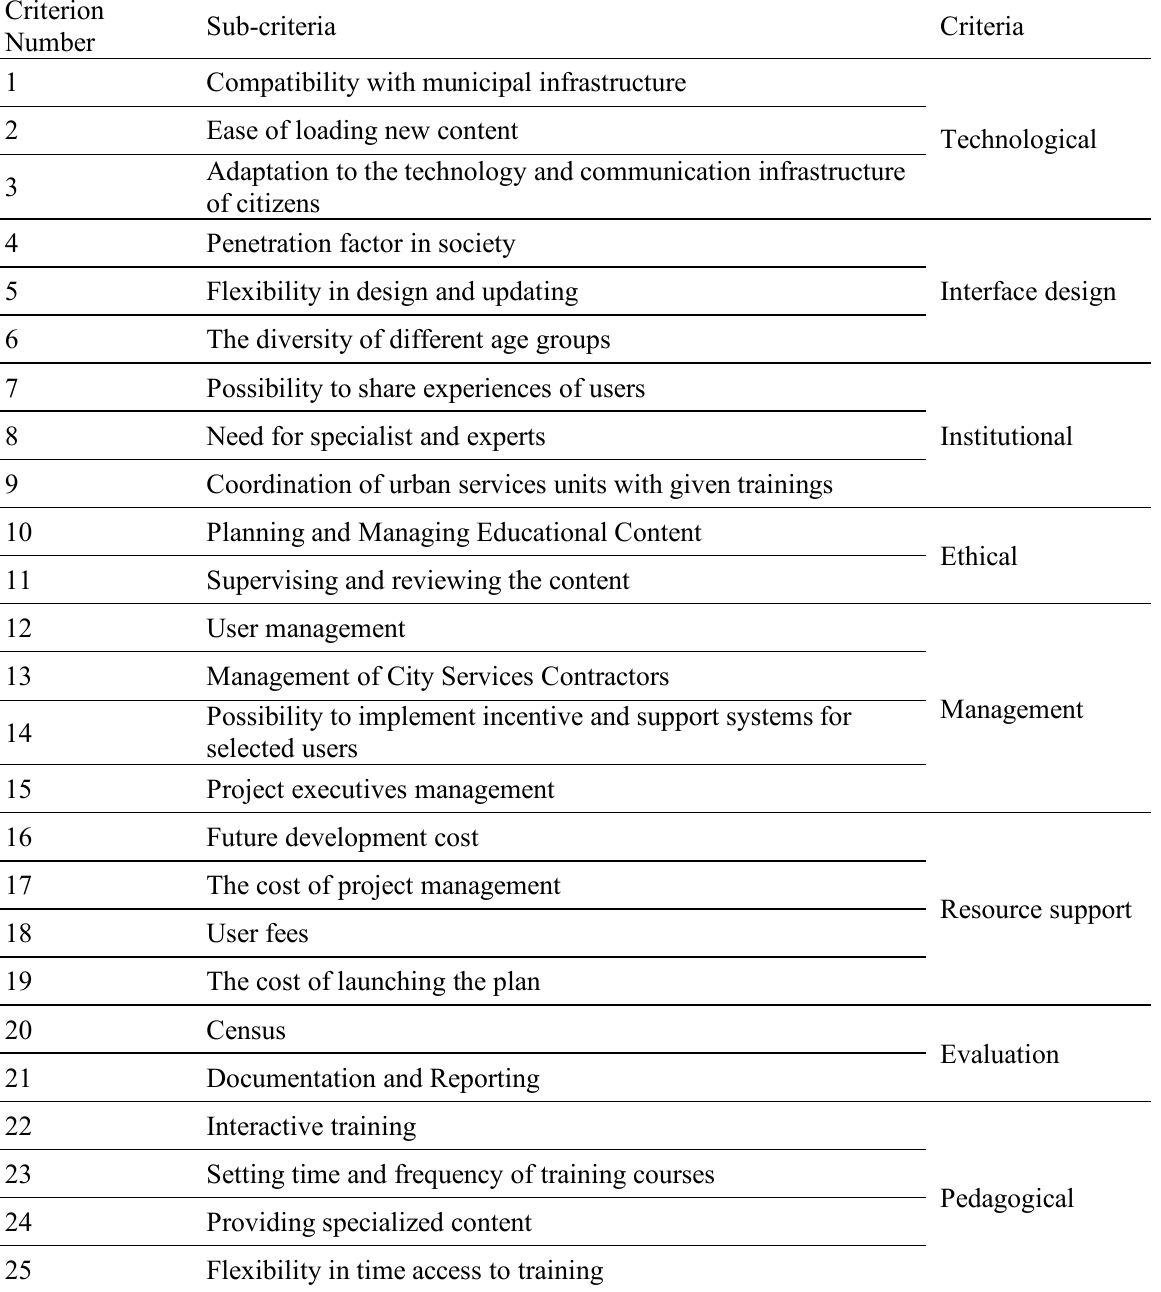
Table 1. Criteria and sub-criteria for decision making based on Khan's conceptual